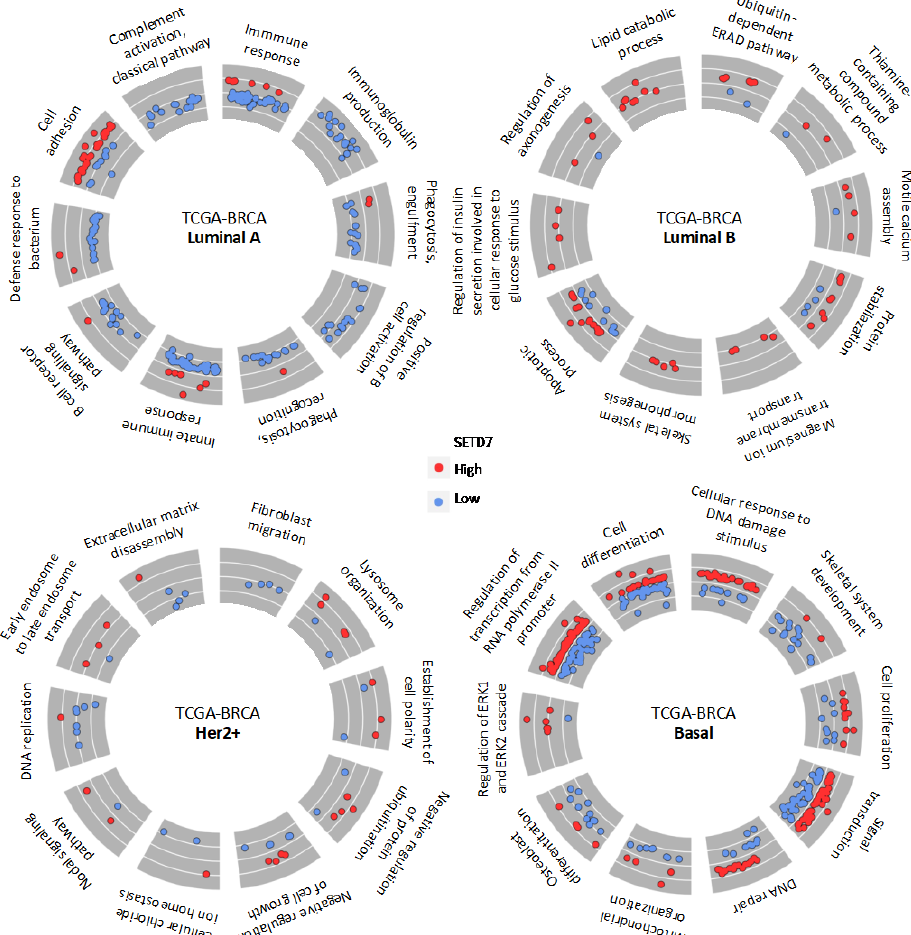
Figure 3. Top 10 biological processes overrepresented among the genes associated with SETD7 differential expression (high and low) and unique for each subtype.